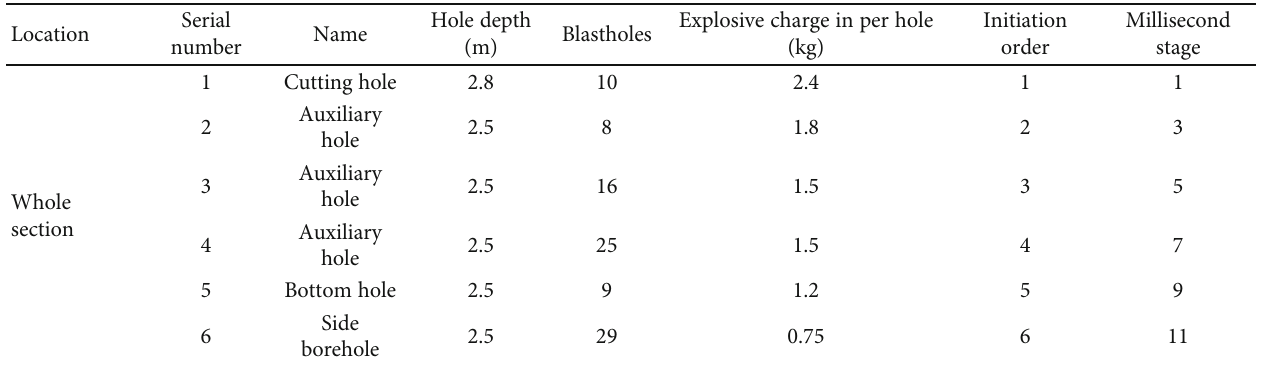
Table 3: Hole arrangement